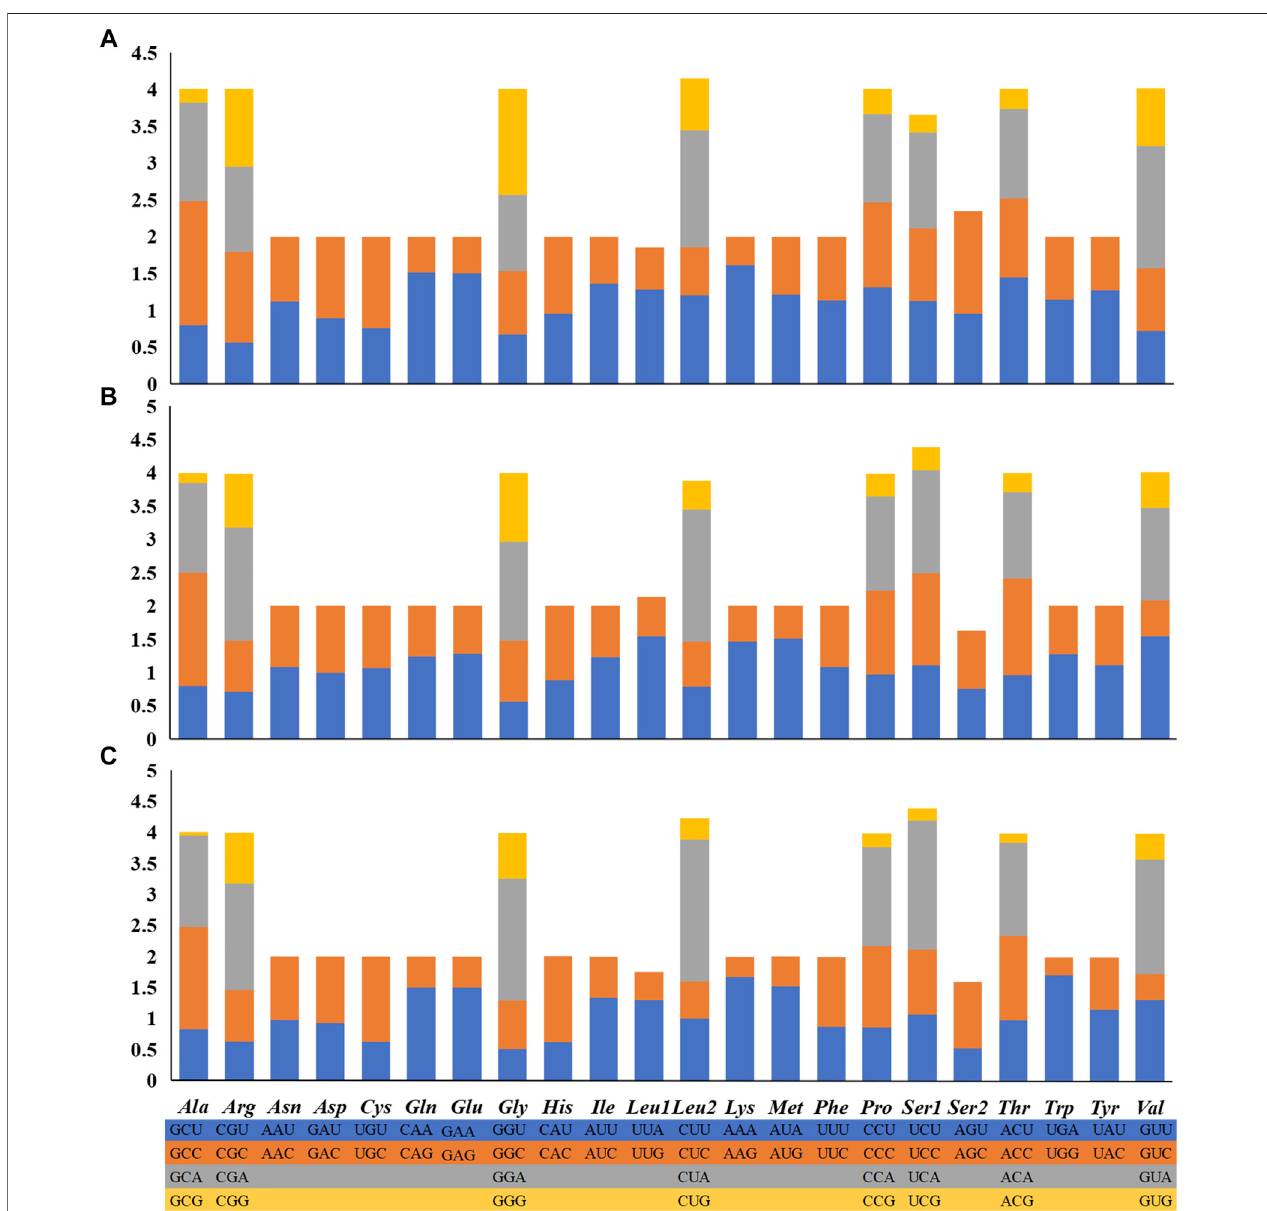
FIGURE 2 | Mitochondrial genome maps of the three Garra in this study. (A) Garra dengba mitochondrial genome visualization ring diagram. (B) Garra tibetana mitochondrial genome visualization ring diagram. (C) Garra yajiangensis mitochondrial genome visualization ring diagram. Genes encoded on the heavy or light strands are shown at the outside or inside of the circular gene map, respectively. The mitochondrial genome visualization ring diagram of the three species show the same structure and all have two control regions.